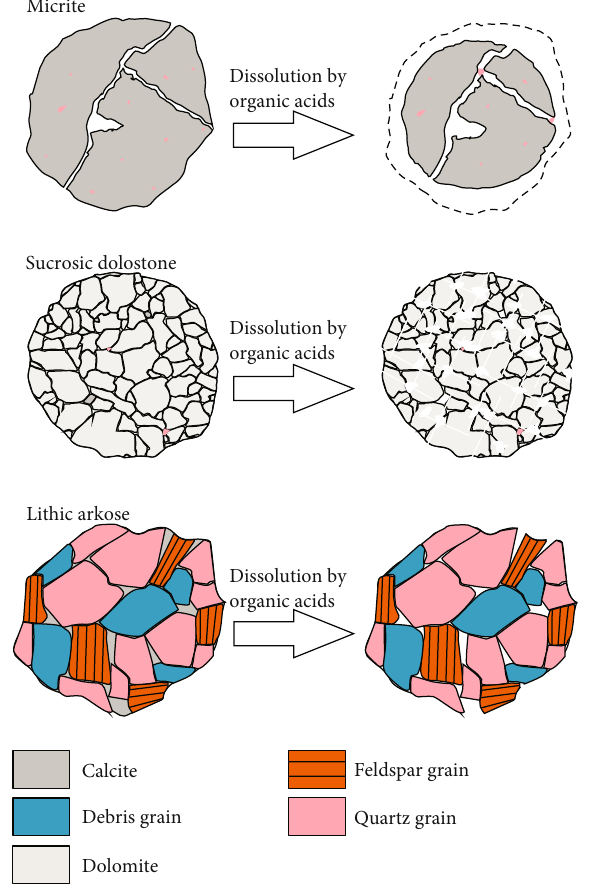
Figure 10: Conceptual graph of the dissolution e ff ect of organic acids on selected reservoir rocks. All rock compositions and minerals of the studied samples were drawn according to rock compositions and textures reported in previous studies [24, 26,